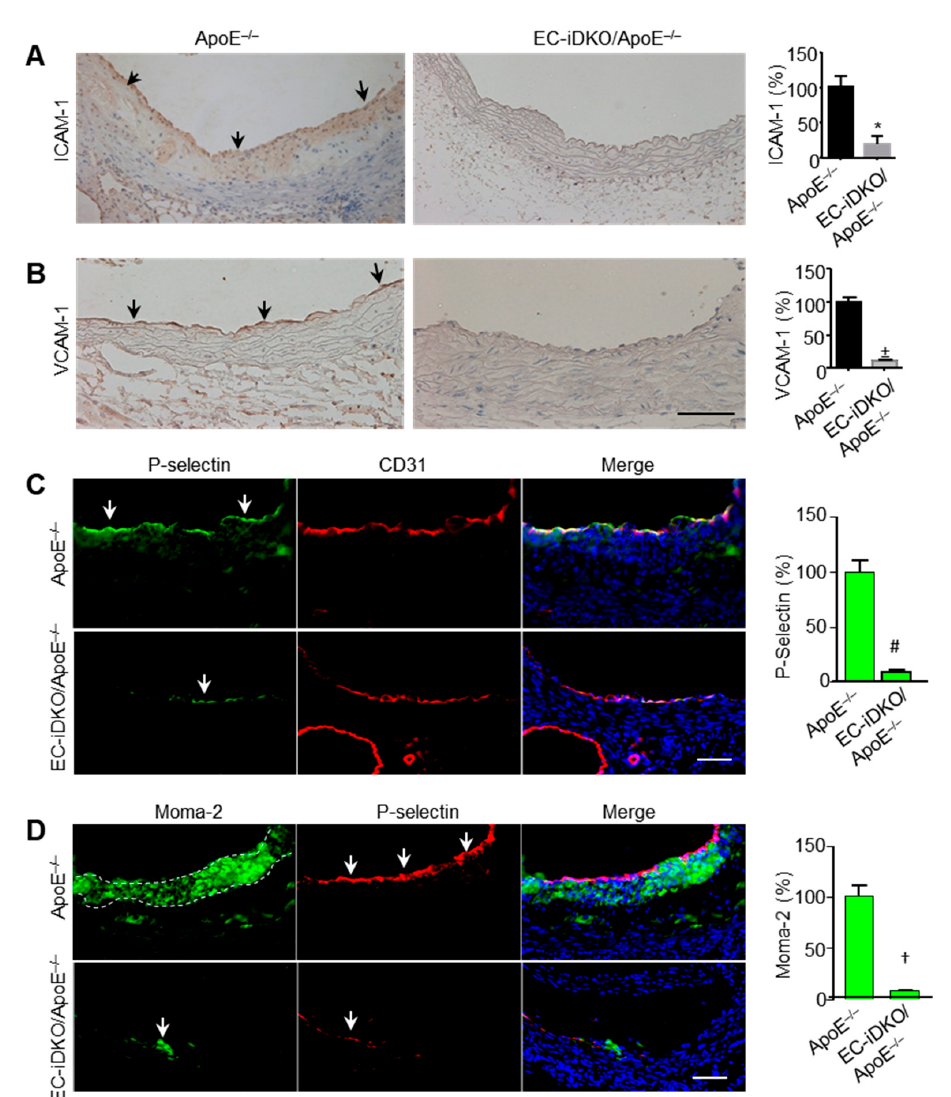
Figure 4. Epsin loss attenuates adhesion molecules expression in ApoE-null mice. ( A , B ) ICAM-1 and VCAM-1 expression in EC-iDKO/ApoE − / − and ApoE − / − mice fed a WD for 8 weeks as determined by immunohistochemical (IHC) staining (n = 5 in each group; *, +, ApoE − / − vs . EC-iDKO/ApoE − / − ; p < 0.001). Black arrows indicate ICAM-1 or VCAM-1. Scale bar = 100 µm. ( C ) P-selectin and CD31 staining in the endothelium of aortic roots from ApoE − / − and EC-iDKO/ApoE − / − mice fed a WD for 8 weeks (n = 5 mice in each group; # p < 0.01). White arrows indicate P-selectin. Scale bar = 100 µm. ( D ) Moma-2 and P-selectin staining in ApoE − / − and EC-iDKO/ApoE − / − aortic roots (n = 5 mice in each group; † p < 0.01). White arrows indicate P-selectin. The dashed line indicates macrophage/monocyte accumulation (Moma-2). Scale bar = 100 µm.